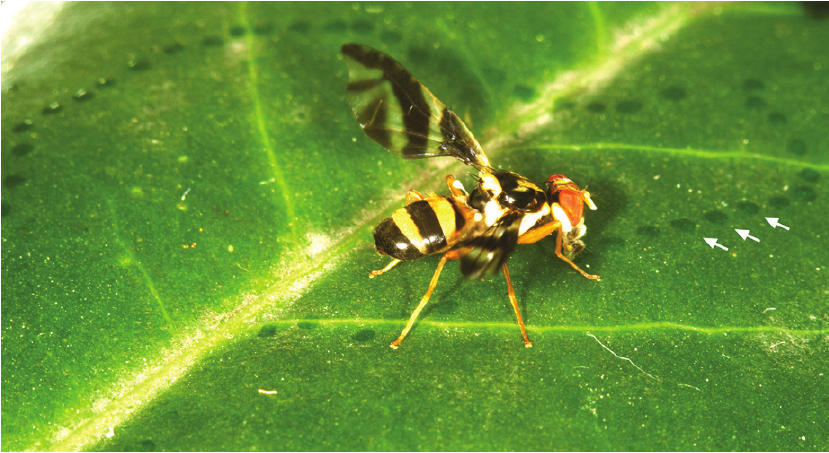
Figure 5. Deposition and reingestion of oral droplets (white arrows) by an A. rufipes male. Another common behavior involving oral droplets was “bubbling”. Both males and females exhibited fast pumping movements of their proboscis in the lab, as well as in the field. Their proboscis was protruded and contracted about two times per second or sometimes slowly stretched out.